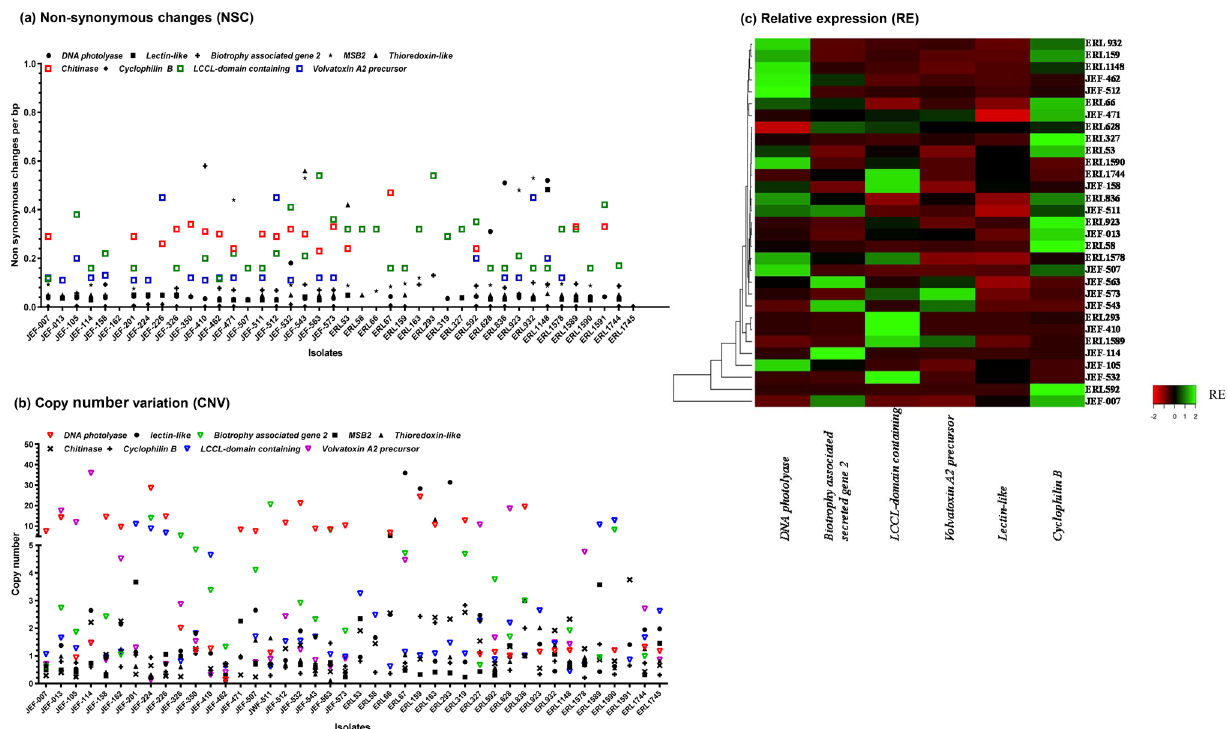
Figure 1. Genetic diversity of B. bassiana isolates. The diversity was analysed with non-synonymous change (NSC) ( a ) and copy number variation (CNV) ( b ) of nine genes in 42 B. bassiana isolates. The graphs were plotted using GraphPad Prism 5 (Inc., San Diego, CA, USA), and the coloured symbols represent genes having high NSC and CVN, respectively. ( c ) Heatmap representing relative expression of six selected genes in different B. bassiana isolates. The heatmap was represented through the online tool (http://www.heatm apper .ca/expre ssion